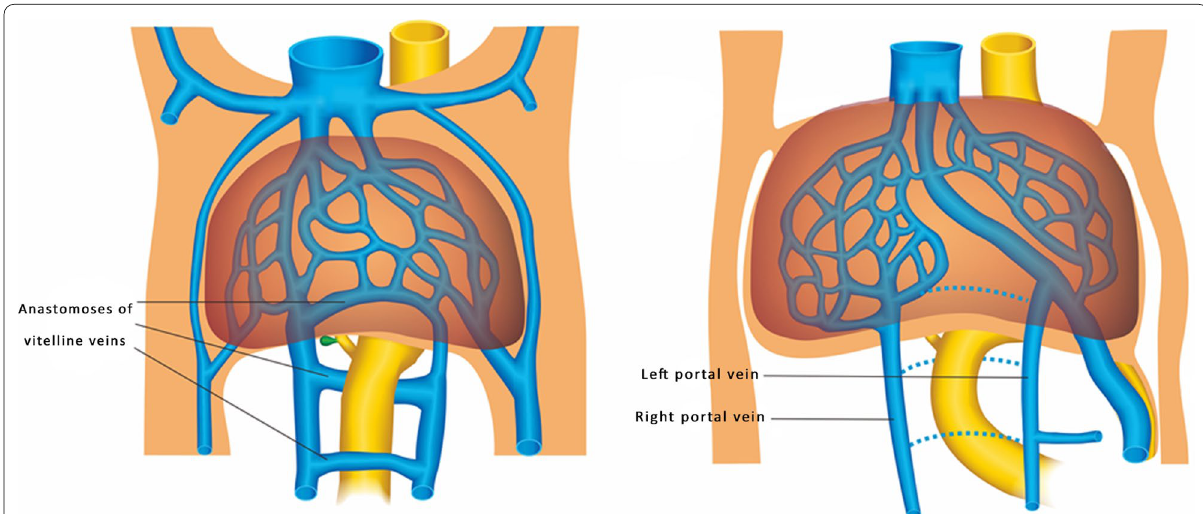
Fig. 4 The embryological scheme of DPV. At the embryonic development, the dorsal and caudal-ventral anastomose of the vitelline veins degenerate, and the caudal part of the two vitelline veins